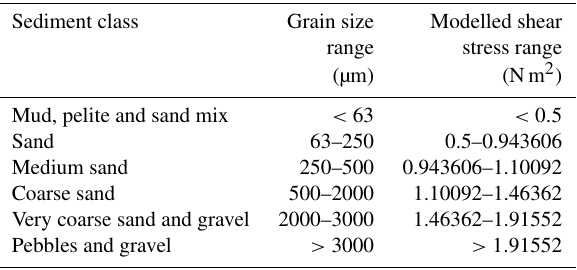
Table 3. Summary of sediment classes, corresponding grain sizes and modelled bed shear stress values for the developed grain size tidal proxy. The sediment classification is as used by Betzler et al. (2015),the largest grain size class was further split into two (Very Coarse Sand and Gravel and Pebbles and Grave).